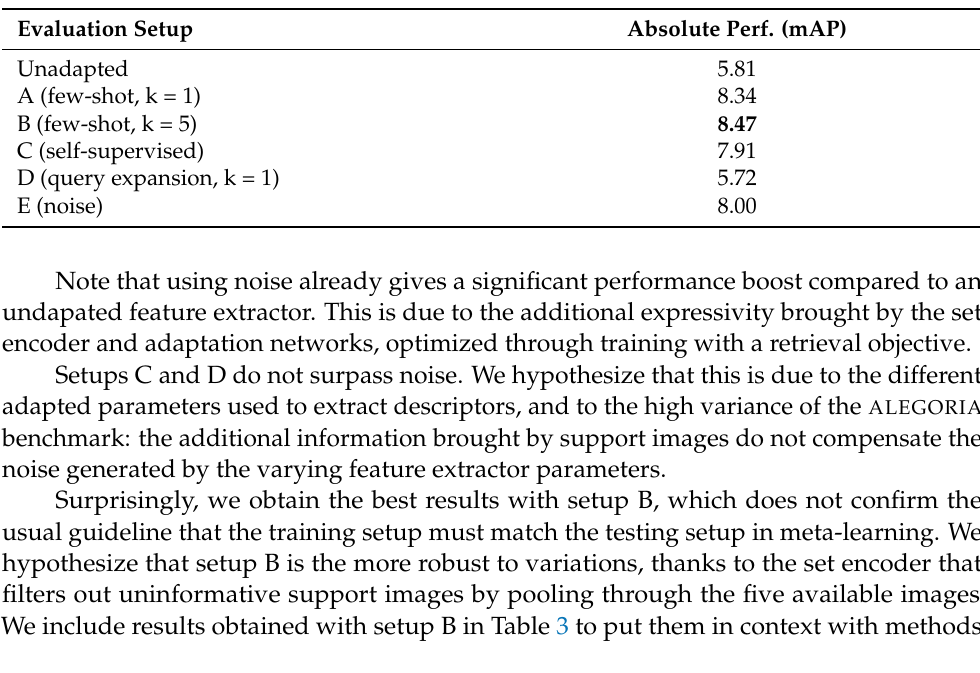
Table 4. Validation experiments for rCNAPS on ALEGORIA